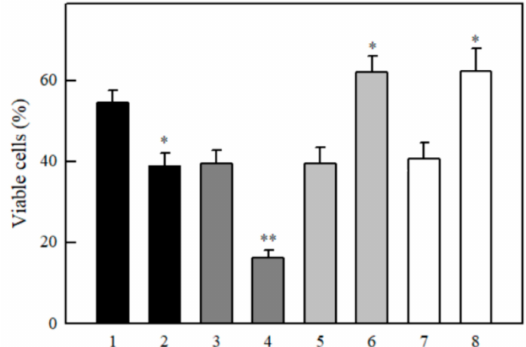
Figure 6. E ff ects of dicoumarol on the cytotoxicity of quinones and ArN → O in MH22a cells. 50 µ M tetramethyl-1,4-benzoquinone (1,2), 5.0 µ M 9,10-phenanthrene quinone (3,4), 50 µ M TPZ (5,6), 10 µ M 7-F-TPZ (7,8) in the absence (1,3,5,7) and in the presence of 20 µ M dicoumarol (2,4,6,8). This dicoumarol concentration did not a ff ect the cell viability in control experiments, 98.5–99.3%. n = 3, p < 0.02 for 1 against 2, 5 against 6, and 7 against 8 (*), p < 0.01 for 3 against 4 (**). The inhibitors of cytochromes P-450 α -naphthoflavone, isoniazide and miconazole enhanced